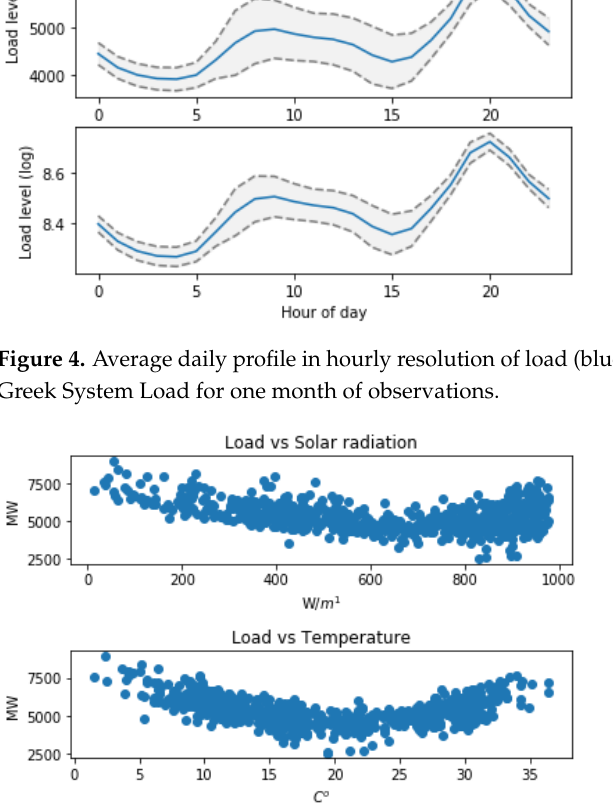
Figure 5. Scatterplot of Greek System Load vs. solar radiation ( above ) and temperature ( below ) for 12